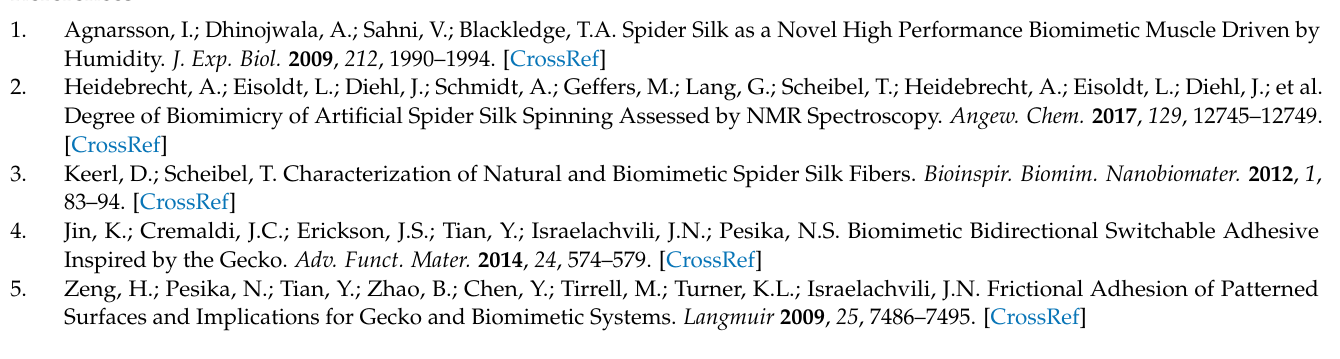
CPF concentration. (R 2 = 0.9919). Table S1. Comparison with other sensing techniques such as